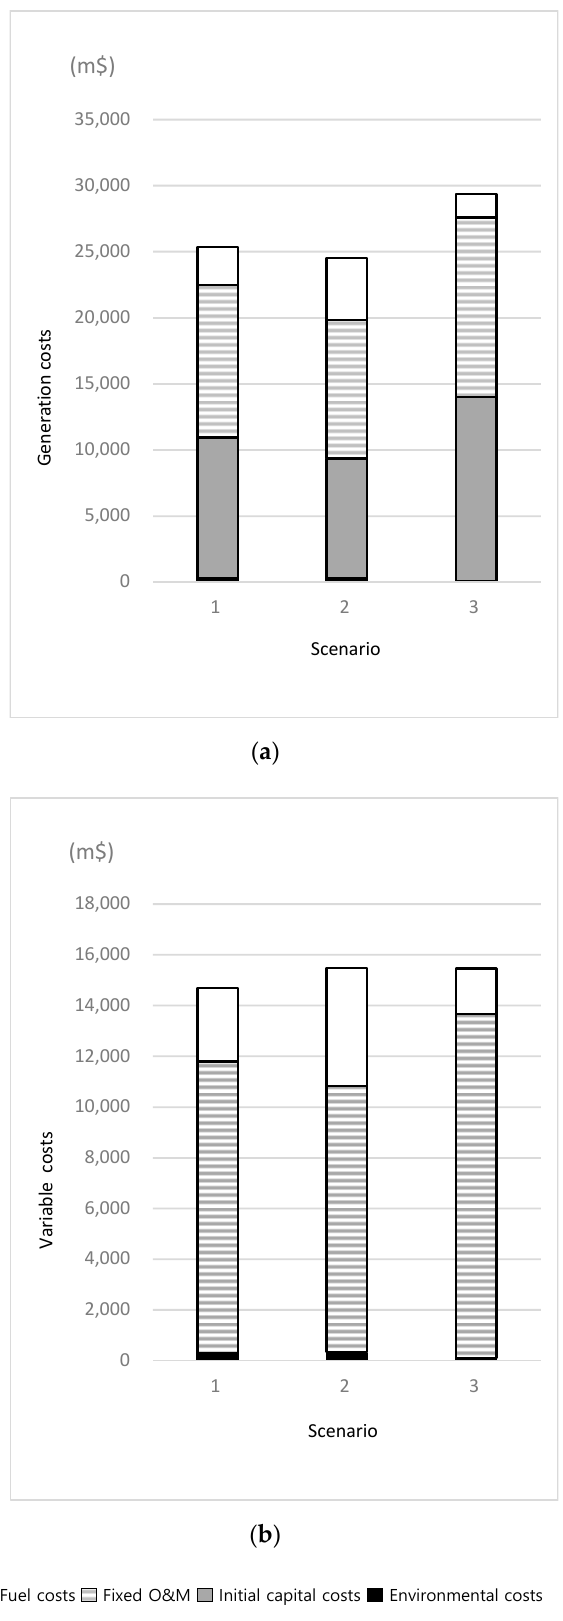
Figure 6. Costs in the Korean power market. ( a ) Generation cost; ( b ) Variable cost.